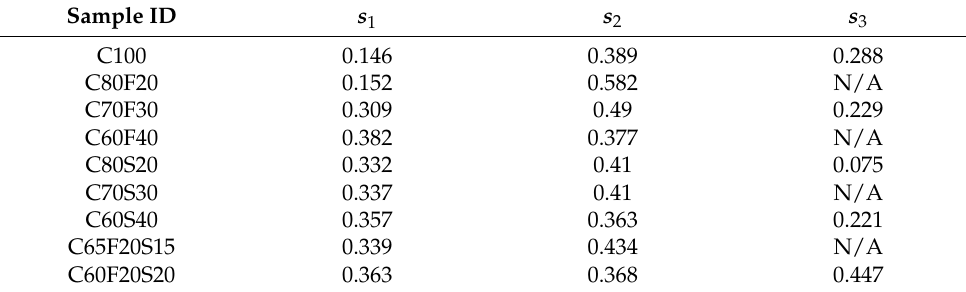
Figure 9. Comparison of the splitting tensile strength development between experimental results and model predictions: ( a ) fly ash group; ( b ) GGBFS group; ( c ) ternary binder group. Table 4. Regression coefficients of all